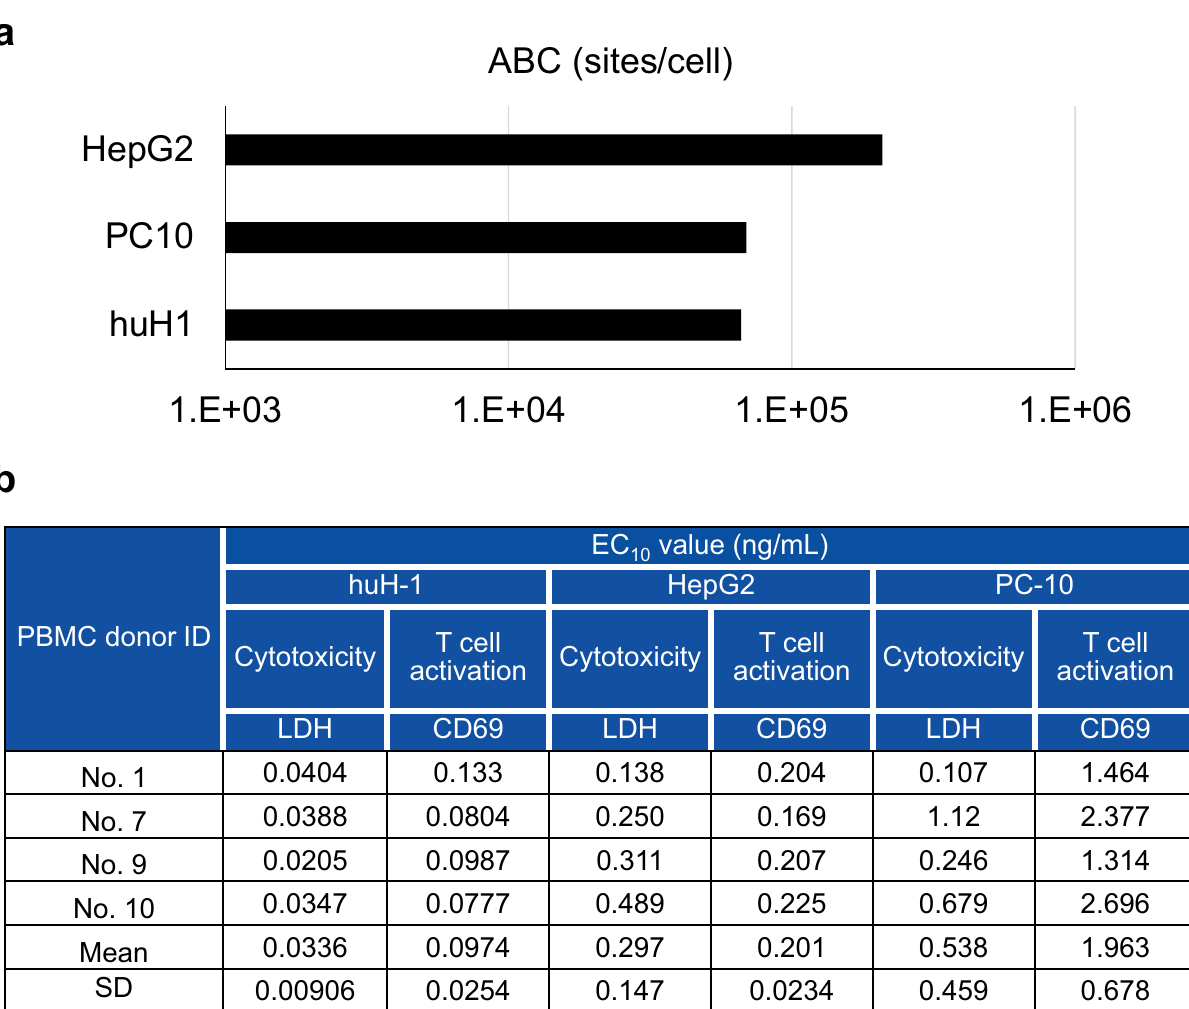
Figure 2. huH-1 is the most sensitive cell line to ERY974. ( a ) GPC3 expression level on the surface of HepG2, PC-10, and huH-1 cells. ABC for each cell line is shown. ( b ) The EC 10 values of cytotoxicity and T cell activation assay of ERY974 in HepG2, PC-10, and huH-1. The PBMCs from four independent donors were used as effector cells. EC 10 was calculated using the sigmoid Emax model. Data are shown as mean ± SD (n = 3). ABC means antigen-binding